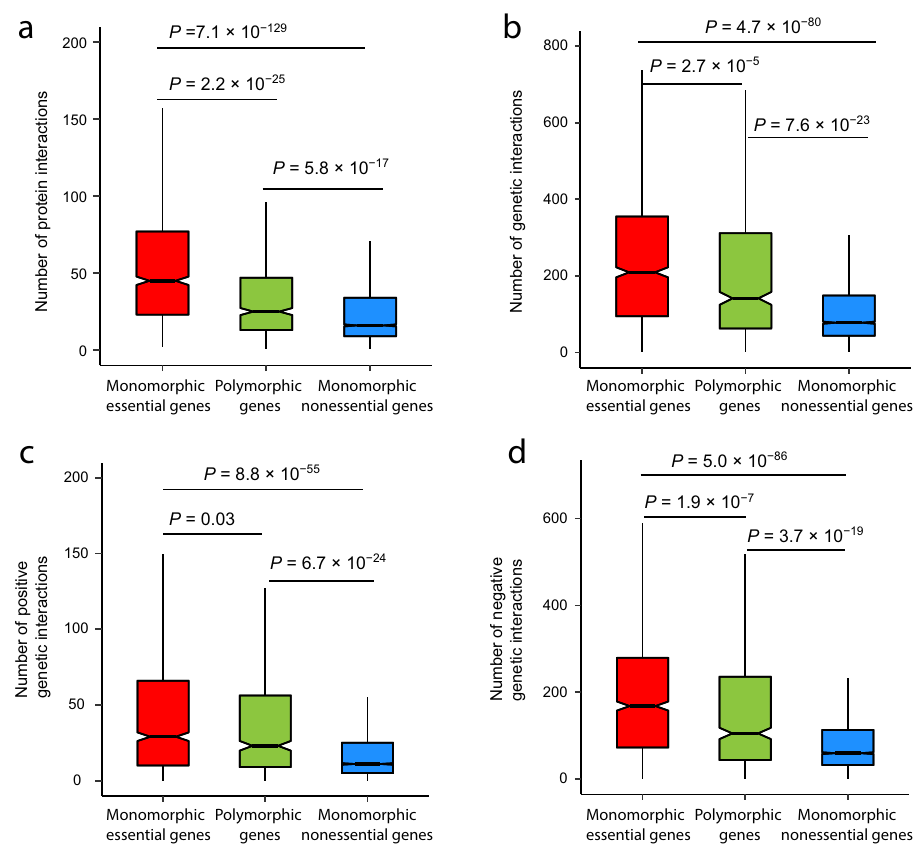
Fig. 3 Numbers of protein and genetic interactions per gene. a Number of protein-protein interaction partners per gene. b Number of genetic interaction partners per gene. c Number of positive genetic interaction partners per gene. d Number of negative genetic interaction partners per gene. In each box plot, the lower and upper edges of a box represent the fi rst ( qu 1 ) and third ( qu 3 ) quartiles, respectively, the horizontal line inside the box indicates the median ( md ), and the whiskers extend to the most extreme values inside inner fences, md ± 1.5( qu 3 − qu 1 ). Notches show the 95% con fi dence interval of the median. P -values are from two-tailed Wilcoxon rank-sum tests. Polymorphic genes ( n = 567) refer to those that are essential in some but not other yeast strains examined. Monomorphic essential genes ( n = 1046) are essential in all examined strains, whereas monomorphic nonessential genes ( n = 4201) are nonessential in all examined strains. Source data are provided as a Source Data fi